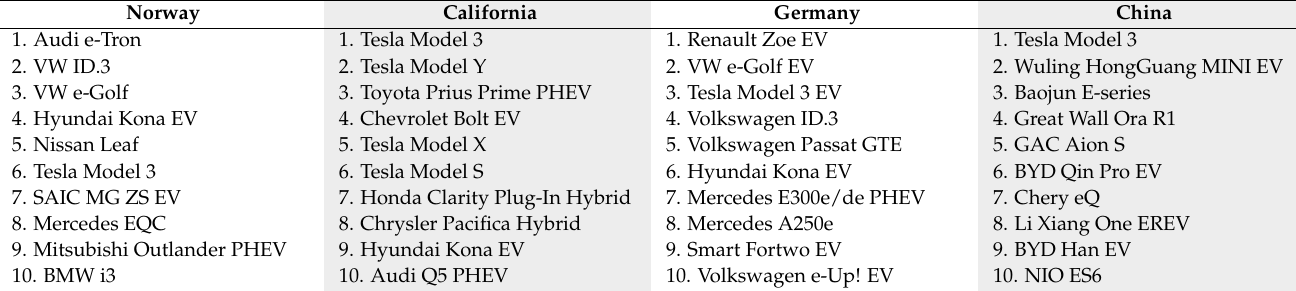
Table 6. The 2020 top 10 best-selling PEV models in Norway, California, Germany, and China, respectively [104]. Norway California Germany